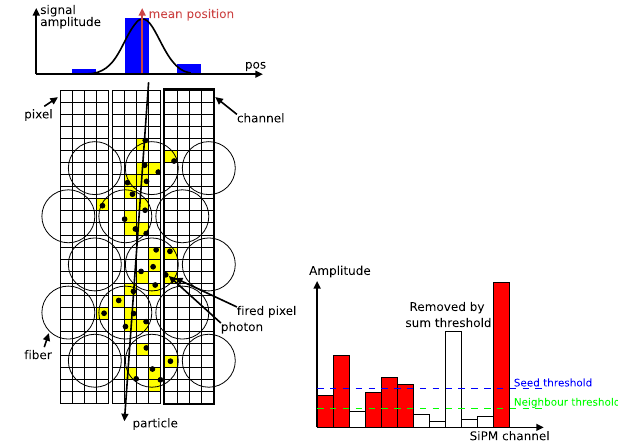
FIG. 5. Left: Signal formation in a SciFi module. Scintillation photons are detected by several SciFi fibers, triggering pixels of the SiPM. Only the sum of signals from the 104 pixels within a SiPM channel is read out. A weighted average is used to measure the exact coordinate of a cluster. Right: Illustration of the clustering algorithm and